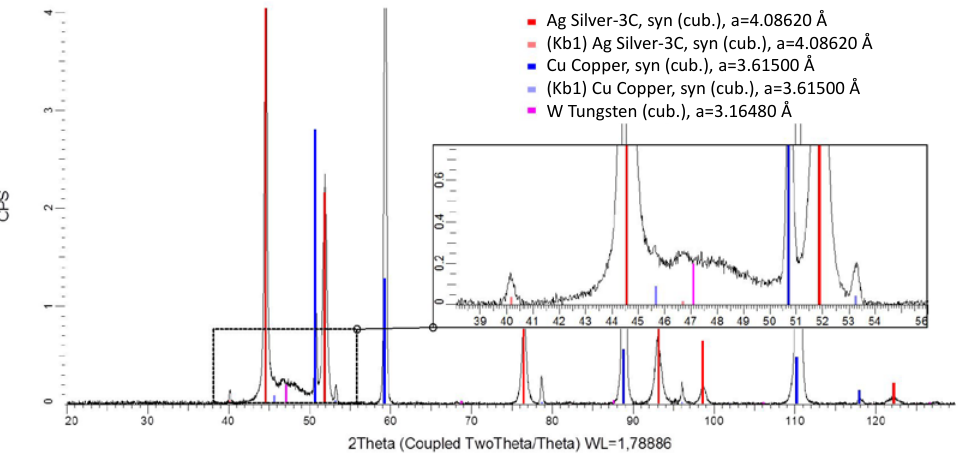
Figure 5. XRD measurement of the Ag–W film with w W = 50% ( x W = 36.9%) W obtained from [EMIm]Cl:AlCl 3 measured with Co-K α radiation. The lattice parameters (a) given in the figure represent the values from the PDF-2 database. For intense peaks, the corresponding peak originating from Co K β radiation can be observed. Table 2. Measurement of the hardness.